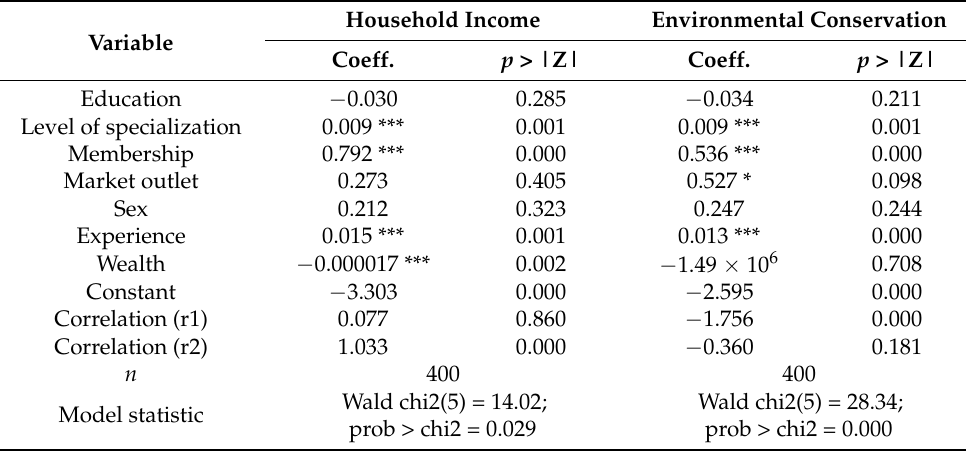
Table 4. Determinants of certification decisions among coffee